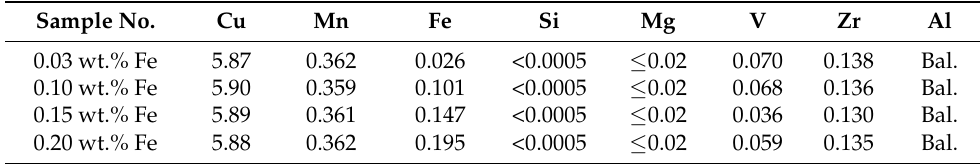
Table 1. The actual chemical compositions of experimental alloys, wt.%. Sample